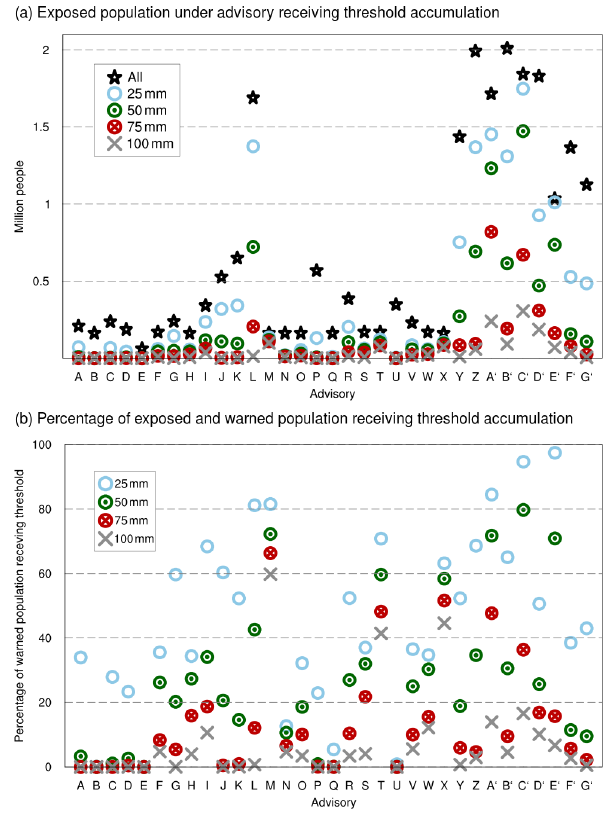
Figure 6. What is the extent of preparedness action implied by advi- sories? (a) The total population living in the warning region (black star) and the number living in that region also receiving at least 25, 50, 75, or 100mm rainfall over the advisory window. (b) Percent- age of the population living in the advisory region and also receiving above-threshold